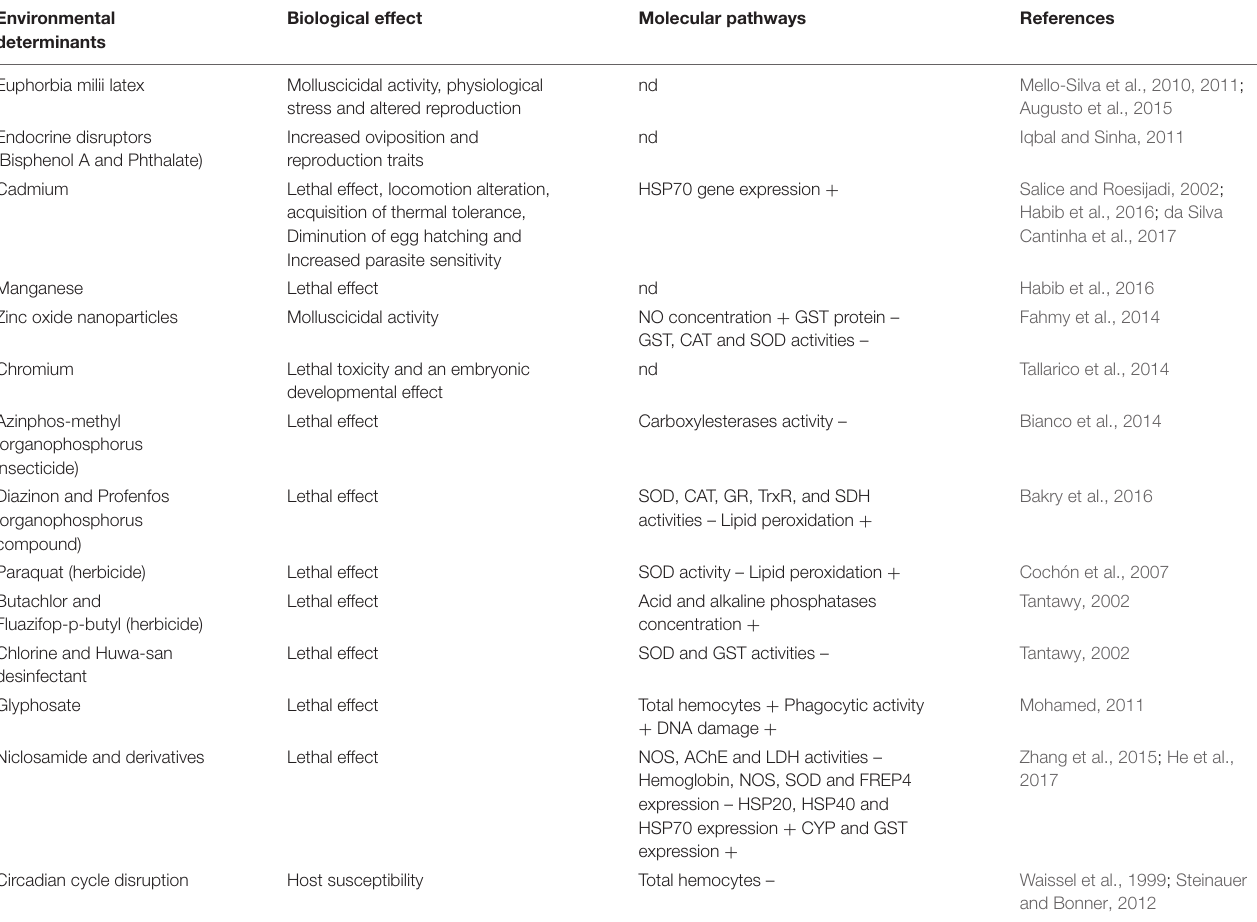
TABLE 1 | Effect of environmental cues on biology and molecular pathways of freshwater intermediate